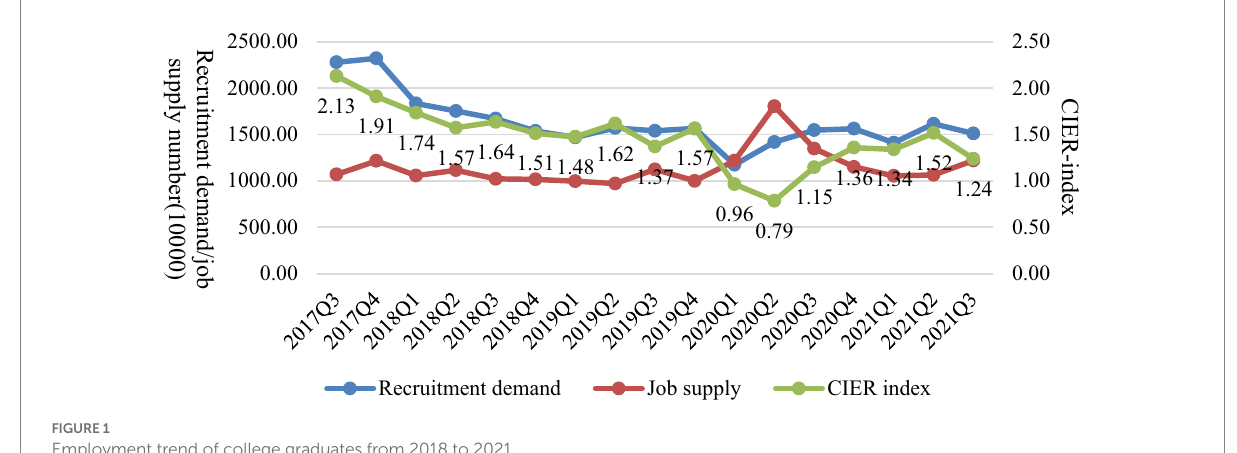
FIGURE 1 Employment trend of college graduates from 2018 to